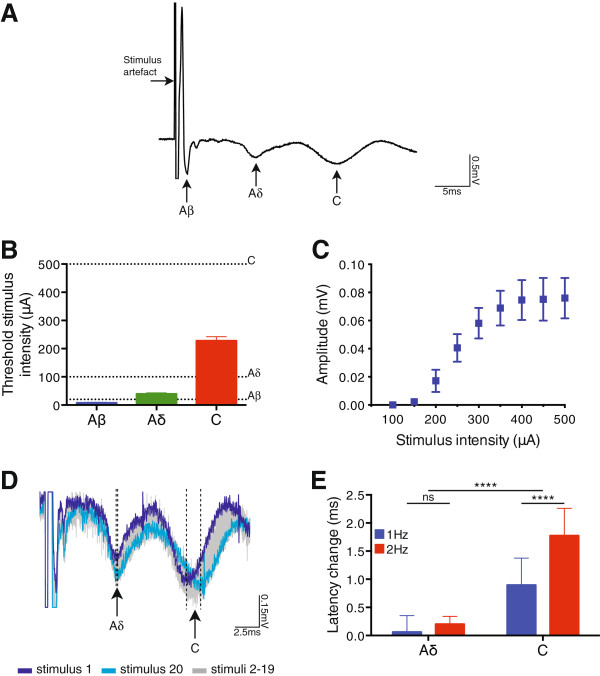
Primary afferent fibre characterisation in compound action potential recordings. A. Representative compound action potential trace recorded from an isolated dorsal root, evoked by 500 μA stimulation, illustrating the fast (A β), medium (A δ) and slow (C) conducting components (average of 10 traces shown). B. Threshold stimulus intensity of the A β-, A δ- and C-fibre components, which differed significantly with fibre type (P < 0.0001, 1-way ANOVA, n = 9). C. Stimulus response relationship for the C-fibre component. D. 1 Hz stimulation of an isolated dorsal root resulted in a prolongation of latency in the C-, but not A δ-fibre component. Broken lines denote the negative peak of the A δ-/C-fibre response during the first and last stimuli. E. Quantification of the latency prolongation demonstrated that the C-fibre, but not A δ-fibre, component exhibited a significant frequency dependent latency prolongation (A δvs. C and 1 Hz vs. 2 Hz, P < 0.0001, 2-way ANOVA). All data presented as mean ± SEM. Dotted lines in B. indicate the dorsal root stimulation intensities (A β, 20 μA; A δ, 100 μA; C, 500 μA) used in the subsequent patch-clamp electrophysiology studies. ∗∗∗∗ P < 0.0001.